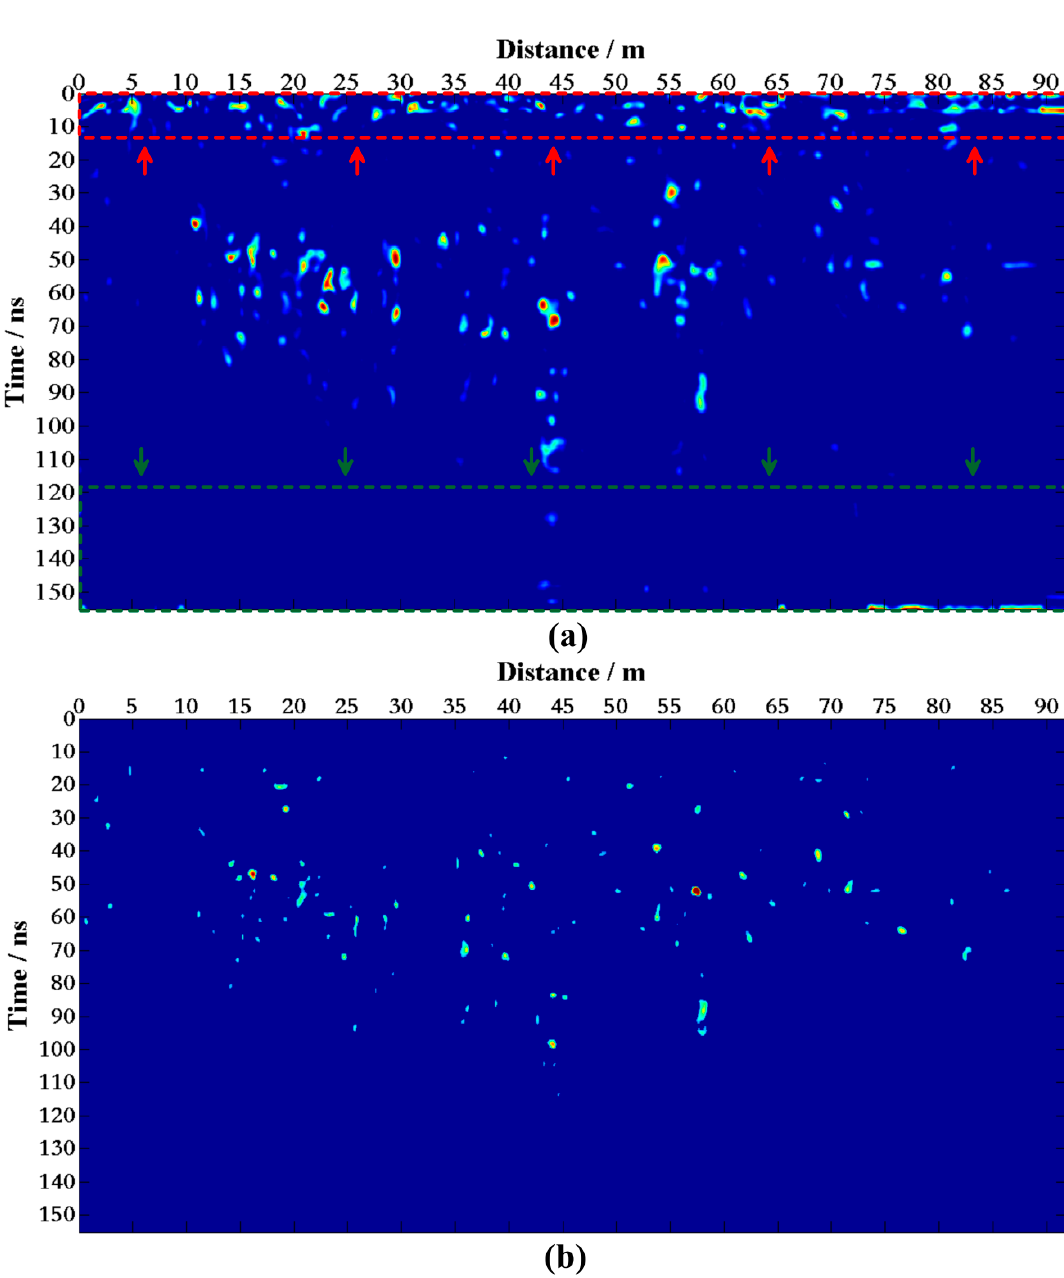
Figure 11. ( a ) Local similarity spectrum for filtered LPR CH-2A and B, ( b ) diffraction section of (a).